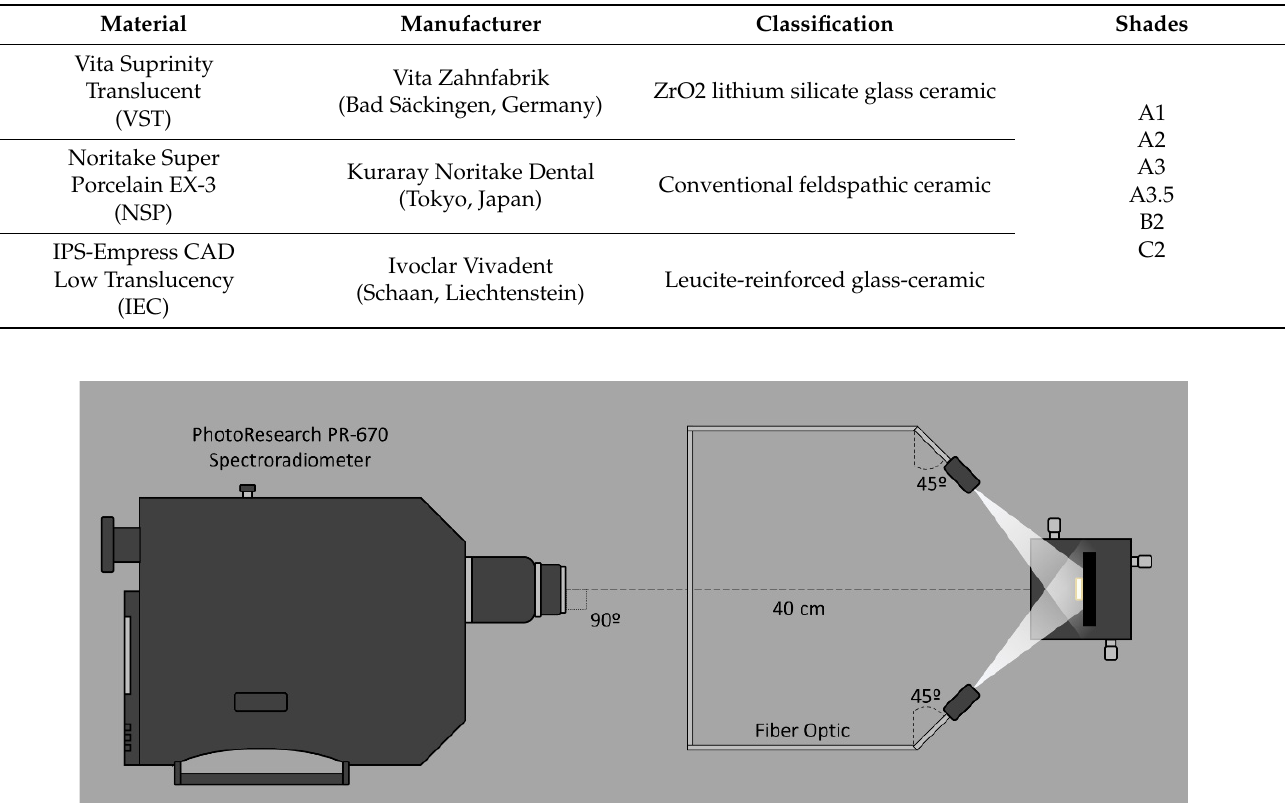
Figure 2. Average spectral reflectance factors on black background of the 18 ceramic materials stud- ied in this study.